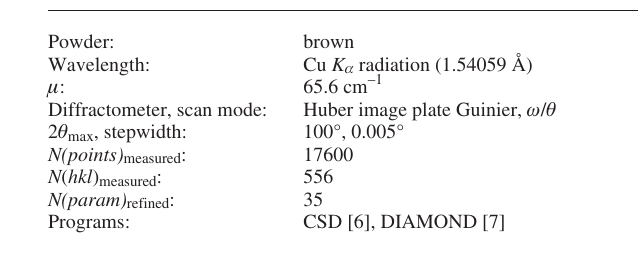
Table 1. Data collection and handling.